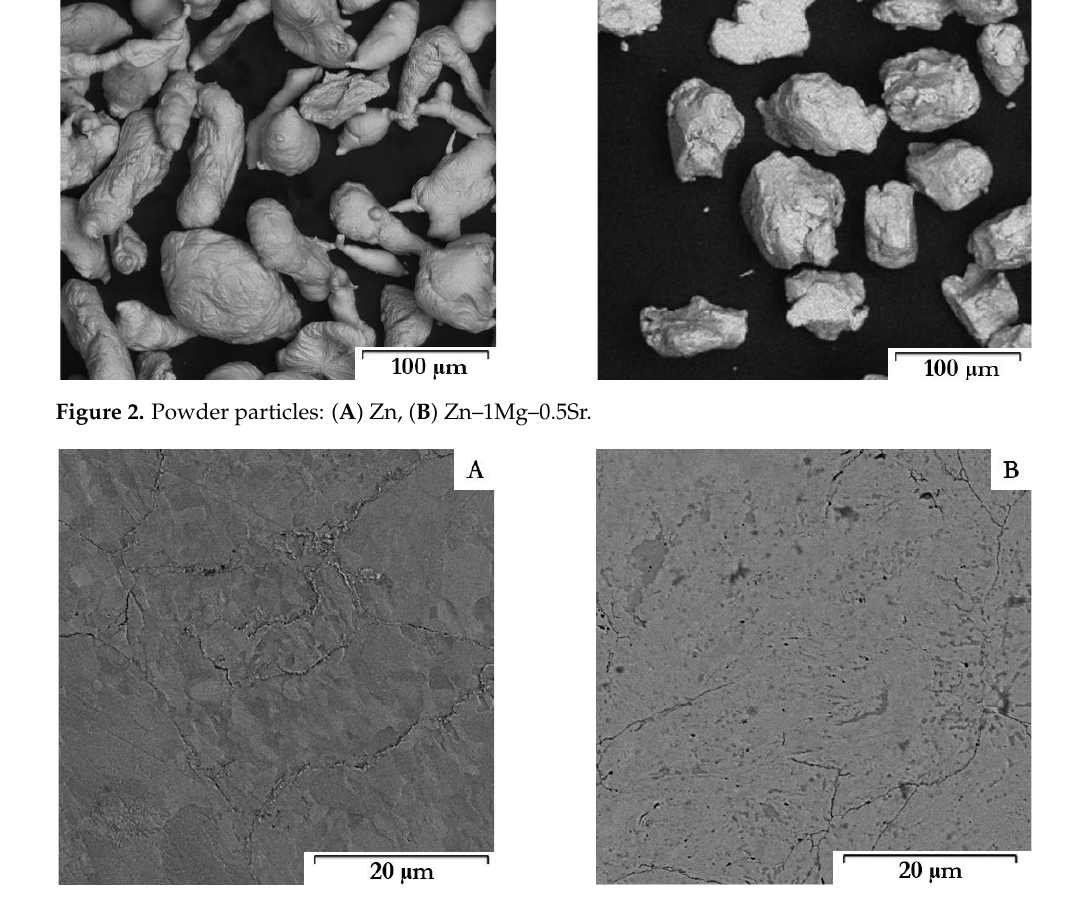
Figure 3. Microstructure of studied materials after SPS – scanning electron microscope (SEM): ( A ) Zn, ( B ) Zn – 1Mg – 0.5Sr.